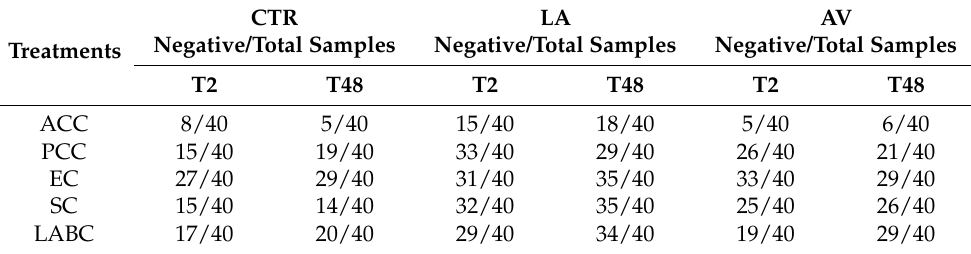
Table 1. Number of samples below the limit of detection for the microbial load considered in treated and untreated surfaces of wild boar carcasses at different storage times. CTR LA AV Negative/Total Samples Negative/Total Samples Negative/Total Samples Treatments T2 T48 T2 T48 T2 T48 ACC 8/40 5/40 PCC 15/40 EC 27/40 29/40 SC 15/40 14/40 32/40 35/40 25/40 26/40 LABC 17/40 20/40 29/40 34/40 19/40